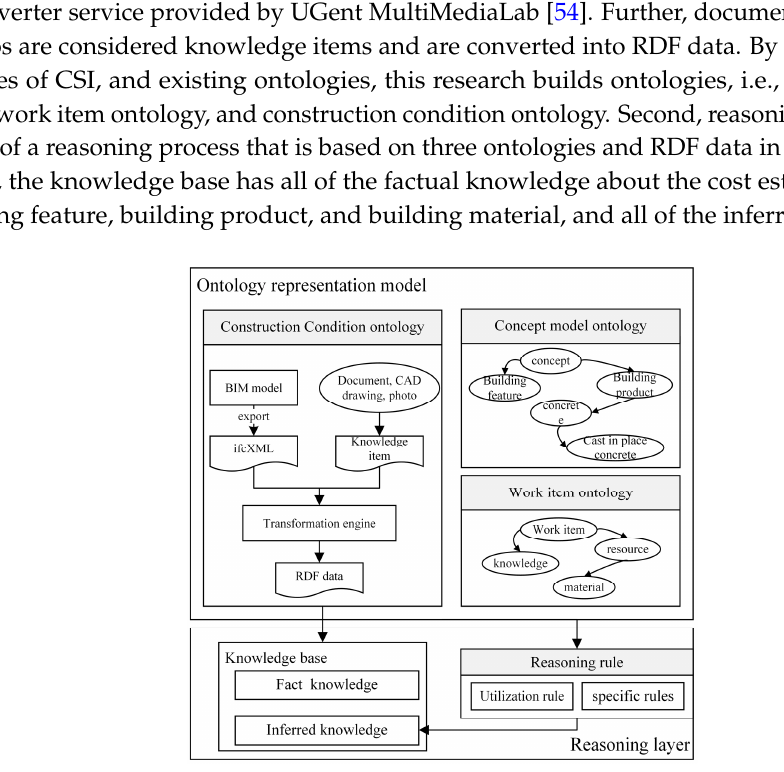
Figure 8. Overall framework for the automated reasoning of cost estimation.